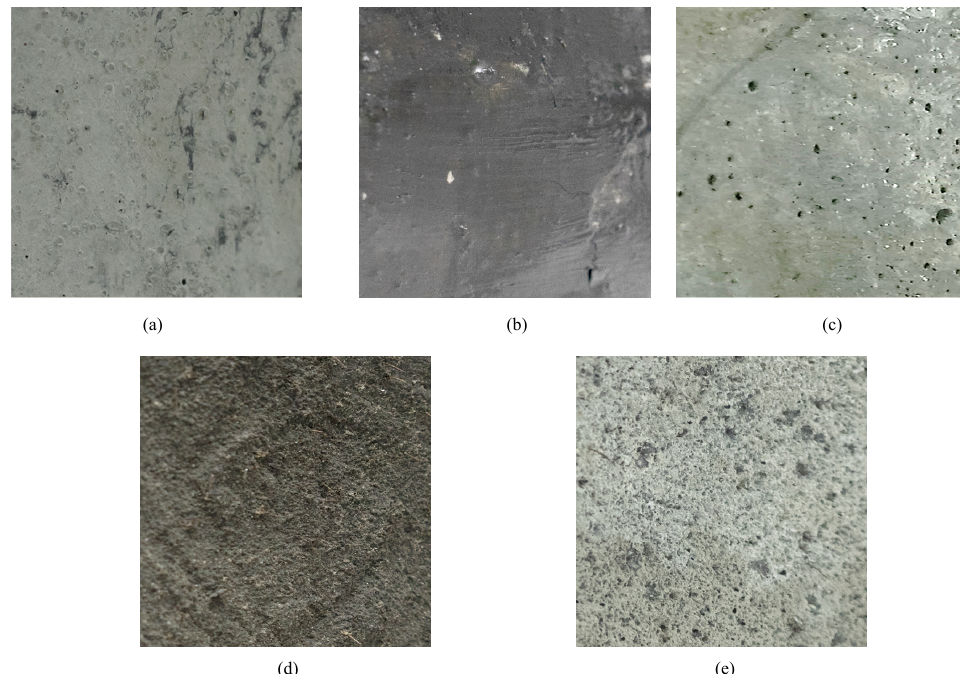
Figure 2. Surface preparation for the precast UHPC substrate: ( a ) no treatment (NT), ( b ) epoxy glue (EG), ( c ) cement-based concrete interface agent (IA), ( d ) exposed fibers using expandable polyethylene foam (EPE), and ( e ) a combination of exposed fibers using expandable polyethylene foam and the interface agent